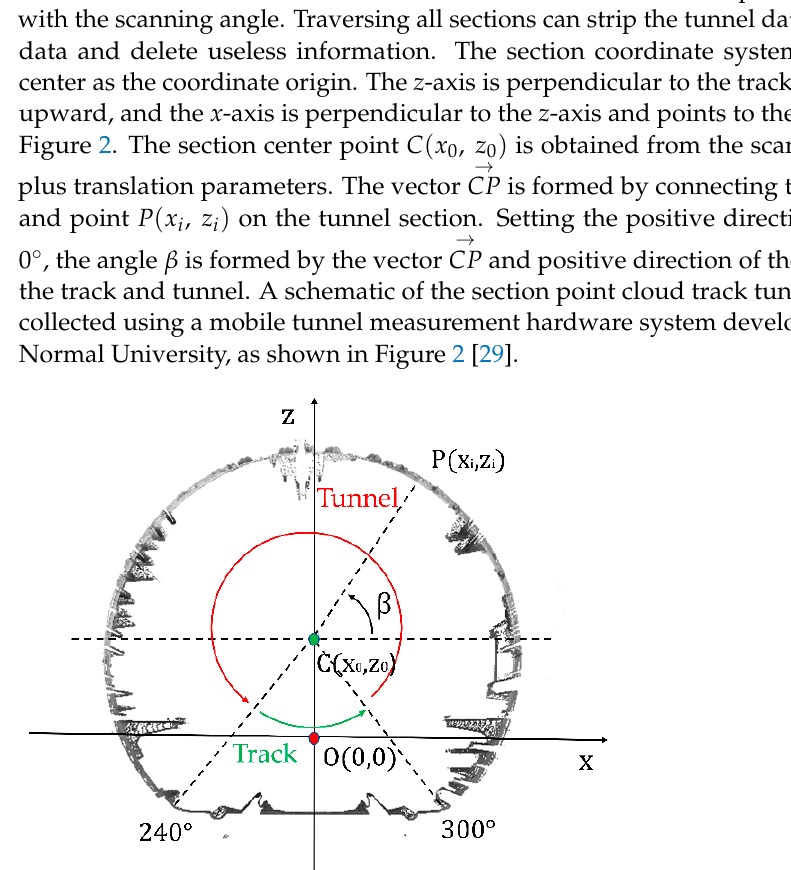
Figure 1. Flowchart of bolt hole extraction and seam location of shield tunnel.